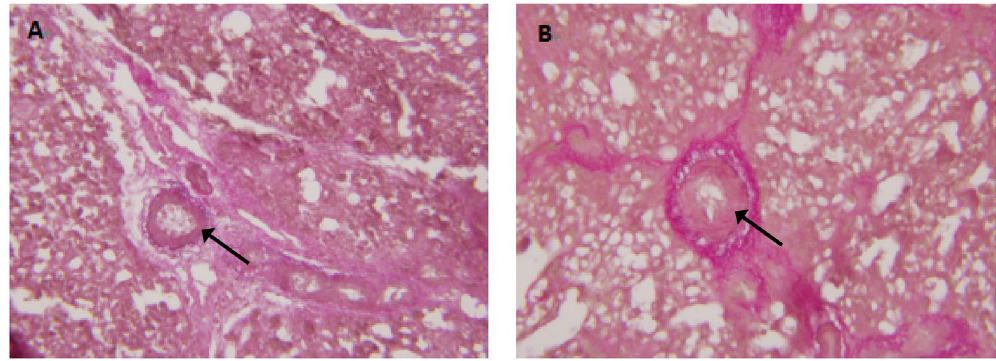
Figure 3. Histological differences in structure of pulmonary arterioles with external diameters of 20–50 μ m (Weigert-Van Gieson × 100), between ( A ) resistant and ( B ) susceptible birds. Magnification, ×